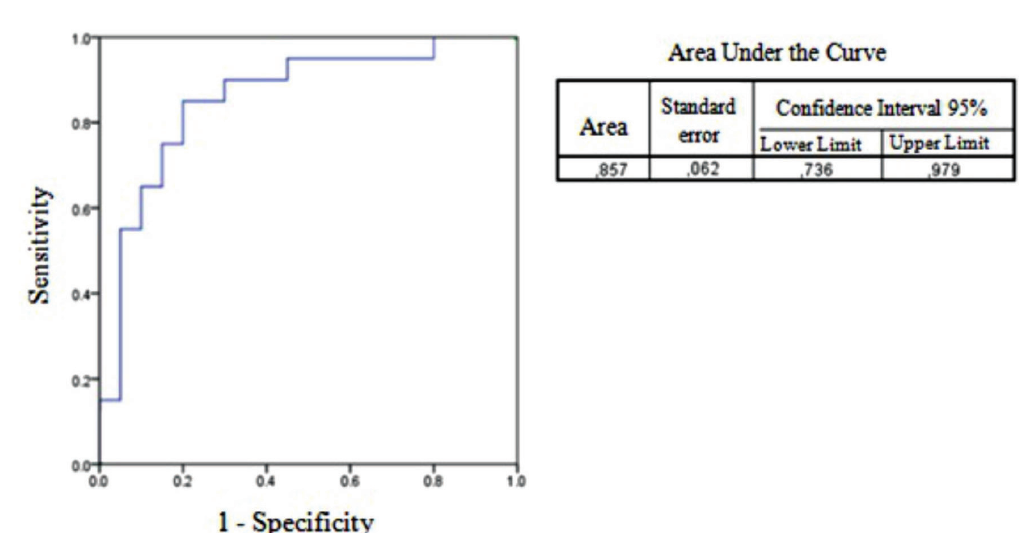
Fig. 2 – ROC curve in the control group to determine the best cutoff point for the variable VTId in evaluating the patency of composite graft